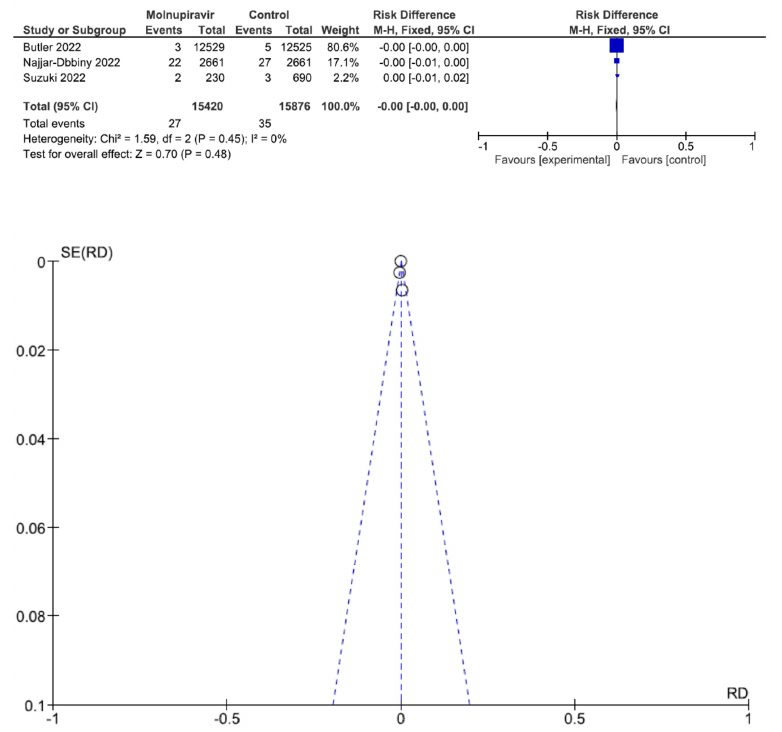
Figure 3. All-cause mortality between molnupiravir and placebo in the treatment of mild to moderate COVID-19 in adult patients [26–31].